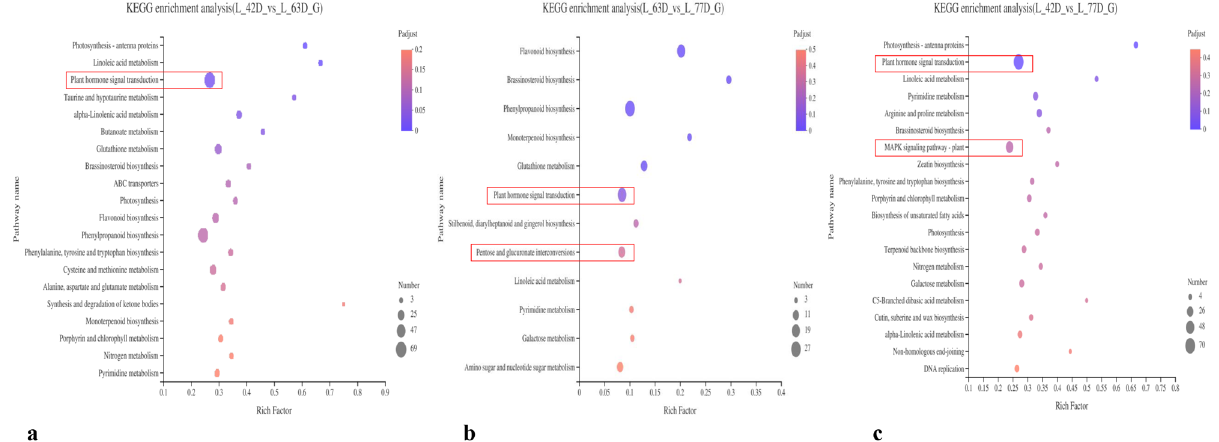
Figure 5. KEGG enrichment of annotated DEGs among 3 stages of “Luntaibaixing” fruit.